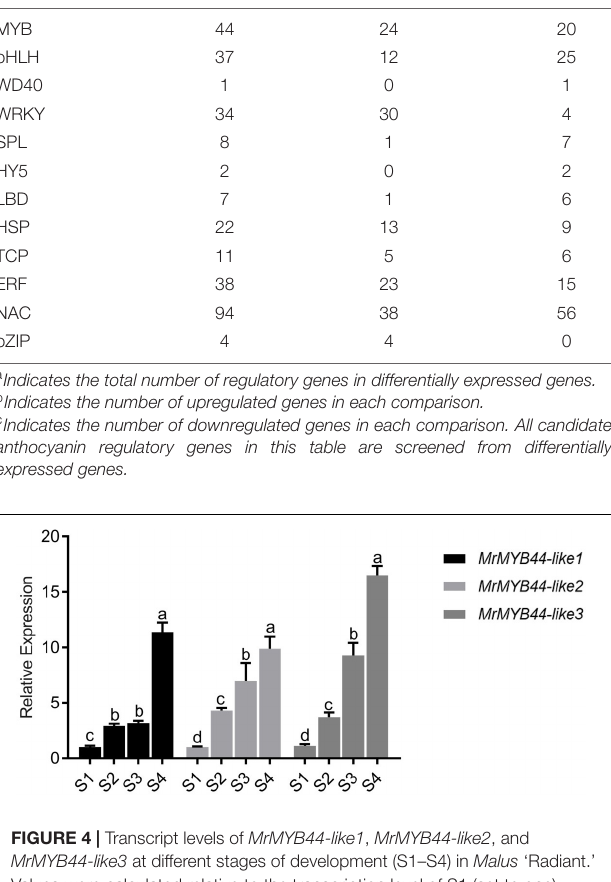
TABLE 2 | Candidate anthocyanin regulatory genes in Malus ‘Radiant.’ Gene family